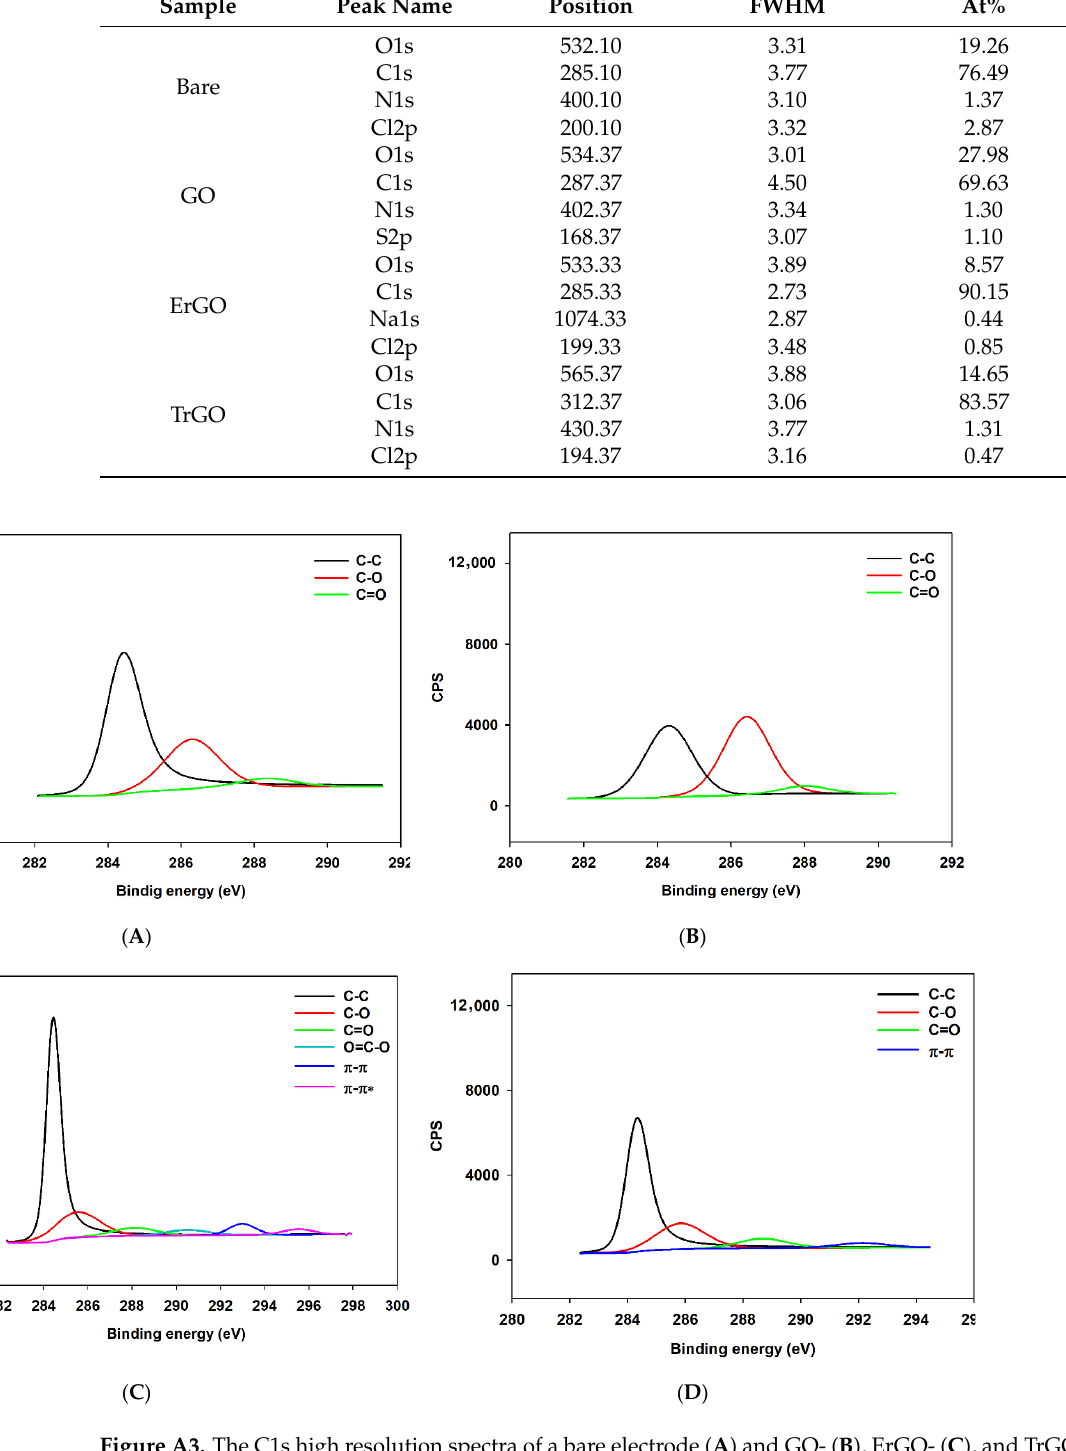
Figure A3. The C1s high resolution spectra of a bare electrode ( A ) and GO- ( B ), ErGO- ( C ), and TrGO- ( D ) modified electrodes.